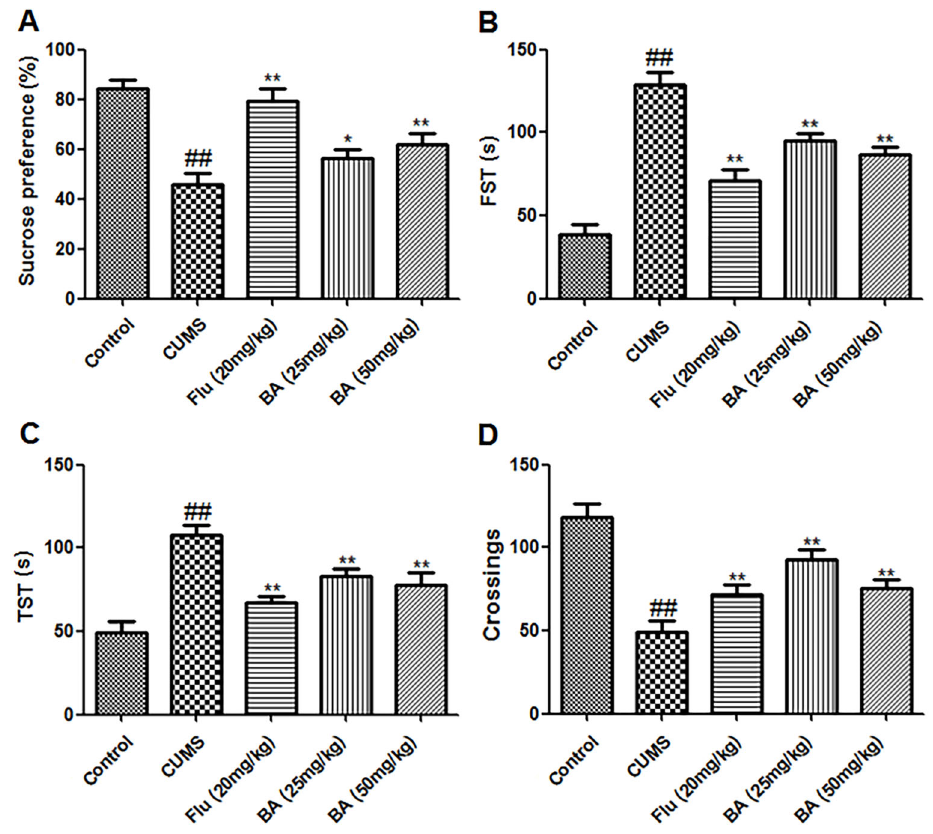
Figure 2. Effects of baicalin (BA) on sucrose consumption ( A ), the forced swimming test (FST) ( B ), the tail suspension test (TST) ( C ), and the open fi eld test ( D ). Data are reported as the means ± SE (n=8). ## P o 0.01 vs control; *P o 0.05 and **P o 0.01 vs CUMS (chronic unpredictable mild stress) (ANOVA). Flu: fl